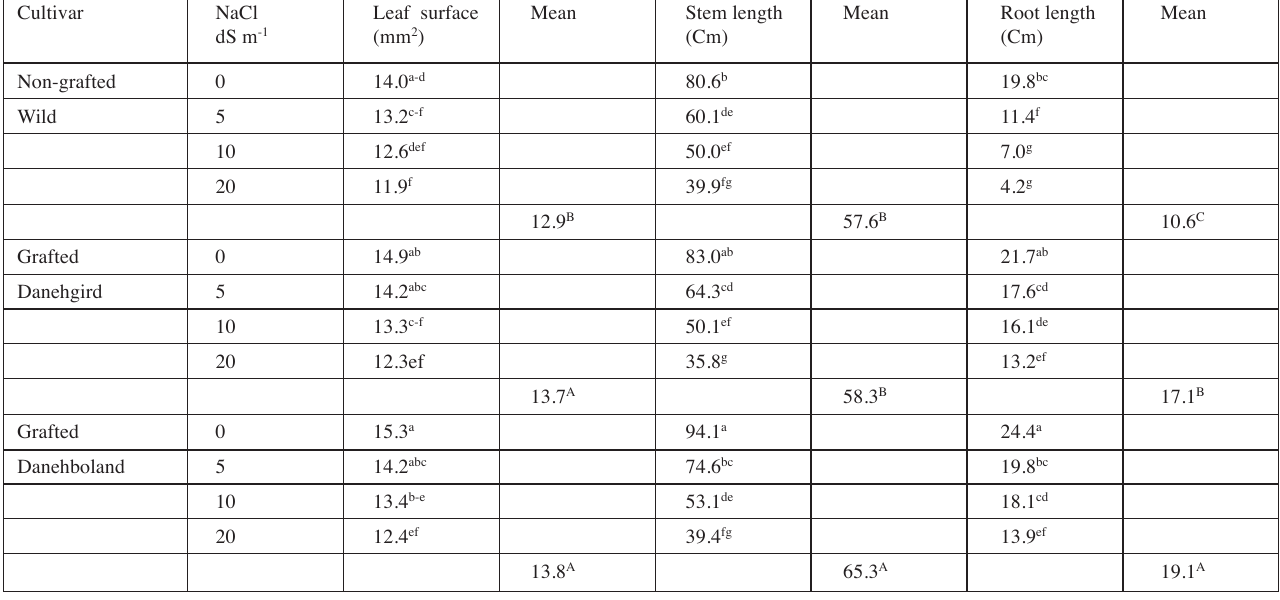
Tab. 1: Sodium chloride effect on leaf surface, stem and root length of non-grafted wild, grated ‘Danehgird’ and ‘Danehboland’ cultivars of Z . spina- chiristi .